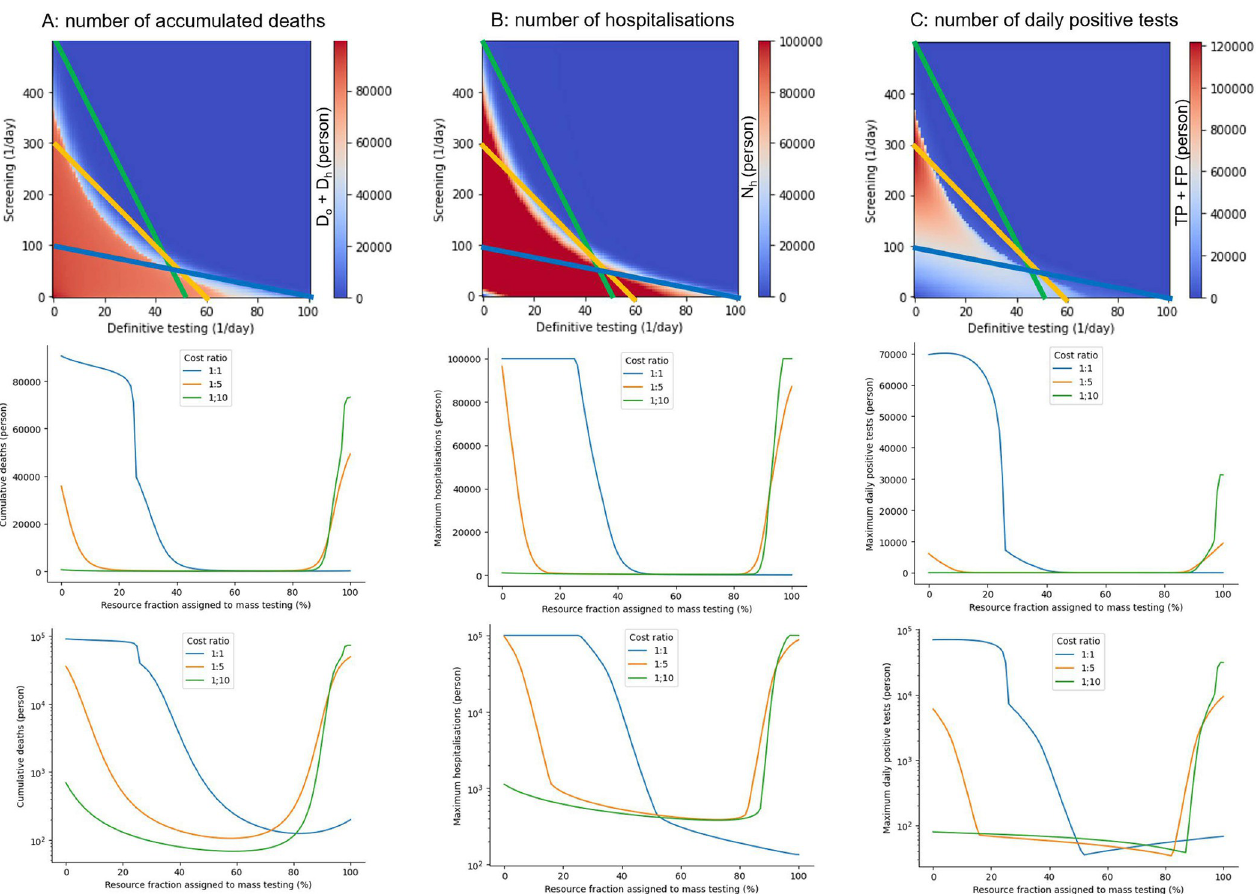
Fig 4. Infectious spread based on the testing strategy. The panels in the first row represent the number of (A) cumulative deaths, (B) maximum hospitalizations, and (C) maximum daily positive tests depending on the rates of follow-up and mass-testing. The three lines in these heatmaps represent the possible testing strategies subject to different total resources for testing with different ratios for the testing costs. L = 500, c f = 1, and c m = 10 in the green line; L = 300, c f = 1, and c m = 5 in the blue line; and L = 100, c f = 1, and c m = 1 in the orange line. The panels in the second row represent the numbers along the three lines in the heatmaps. The panels in the third row represent semilog-plots of the second row.